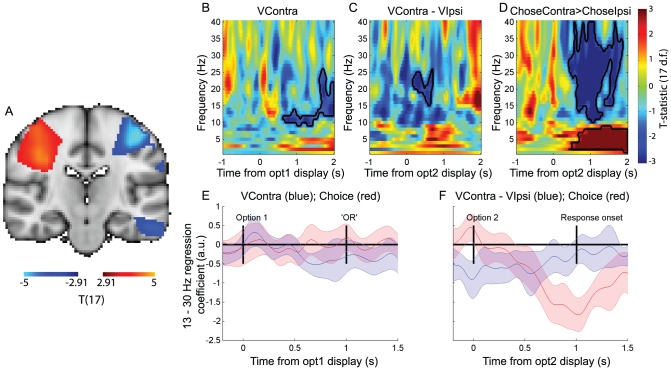
Motor cortex beta desynchronisation represents progression from value representation to choice on ‘sequential’ trials.(A) Statistical parametric map for contrast of beta band (13–30 Hz) activity for right buttonpresses>left buttonpresses, 500 ms–1000 ms after option 2 presentation (thresholded at T(17)>2.91, p<0.005 uncorrected, for display purposes). Warm colors reflect decreased beta desynchronisation in right hemisphere (ipsilateral to movement), cool colors reflect increased beta desynchronisation in left hemisphere (contralateral to movement). (B) Correlates of the value of option 1 at time of option 1 presentation, in hemisphere contralateral to option presentation. Color represents T-statistic; bordered areas reflect significant clusters (cluster-corrected p<0.05; permutation test). (C) Correlates of the value difference between the options contralateral and ipsilateral to the hemisphere, at the time of option 2 presentation. (D) Contrast of trials on which the chosen option is contralateral vs. ipsilateral to the hemisphere, at the time of option 2 presentation. (E) Timecourse of beta band correlates of value of contralateral option (blue and choice (red) at time of option 1 presentation. Lines represent mean +/− 95% confidence intervals across subjects. (Note that as 95% confidence intervals are plotted, rather than standard error of the mean (s.e.m.), error bars are ∼1.96 times wider than when plotting s.e.m.). (F) Timecourse of beta band correlates of value difference (blue) and choice (red) between options contralateral vs. ipsilateral to the hemisphere at time of option 2 presentation.